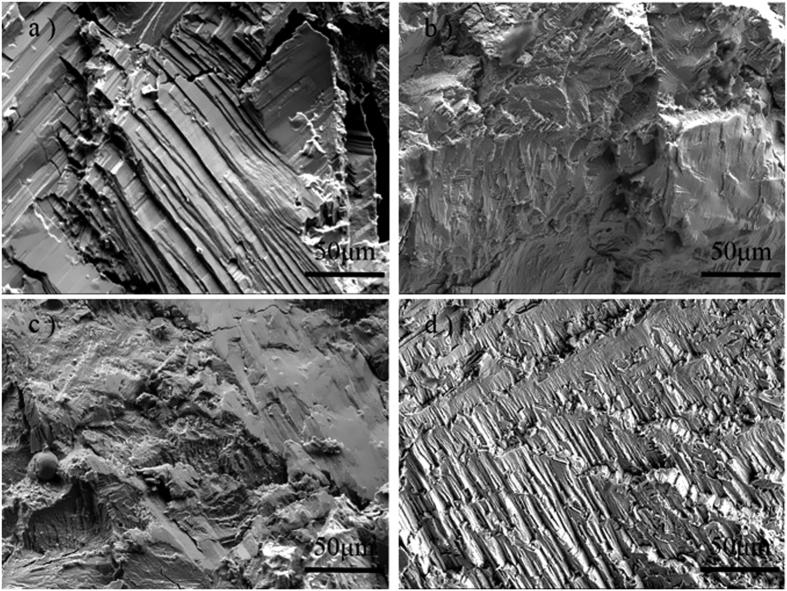
SEM fracture cross-section of Ni50−xFexMn39Sn11 alloys (a) x = 0; (b) x = 3; (c) x = 4; (d) x = 6.